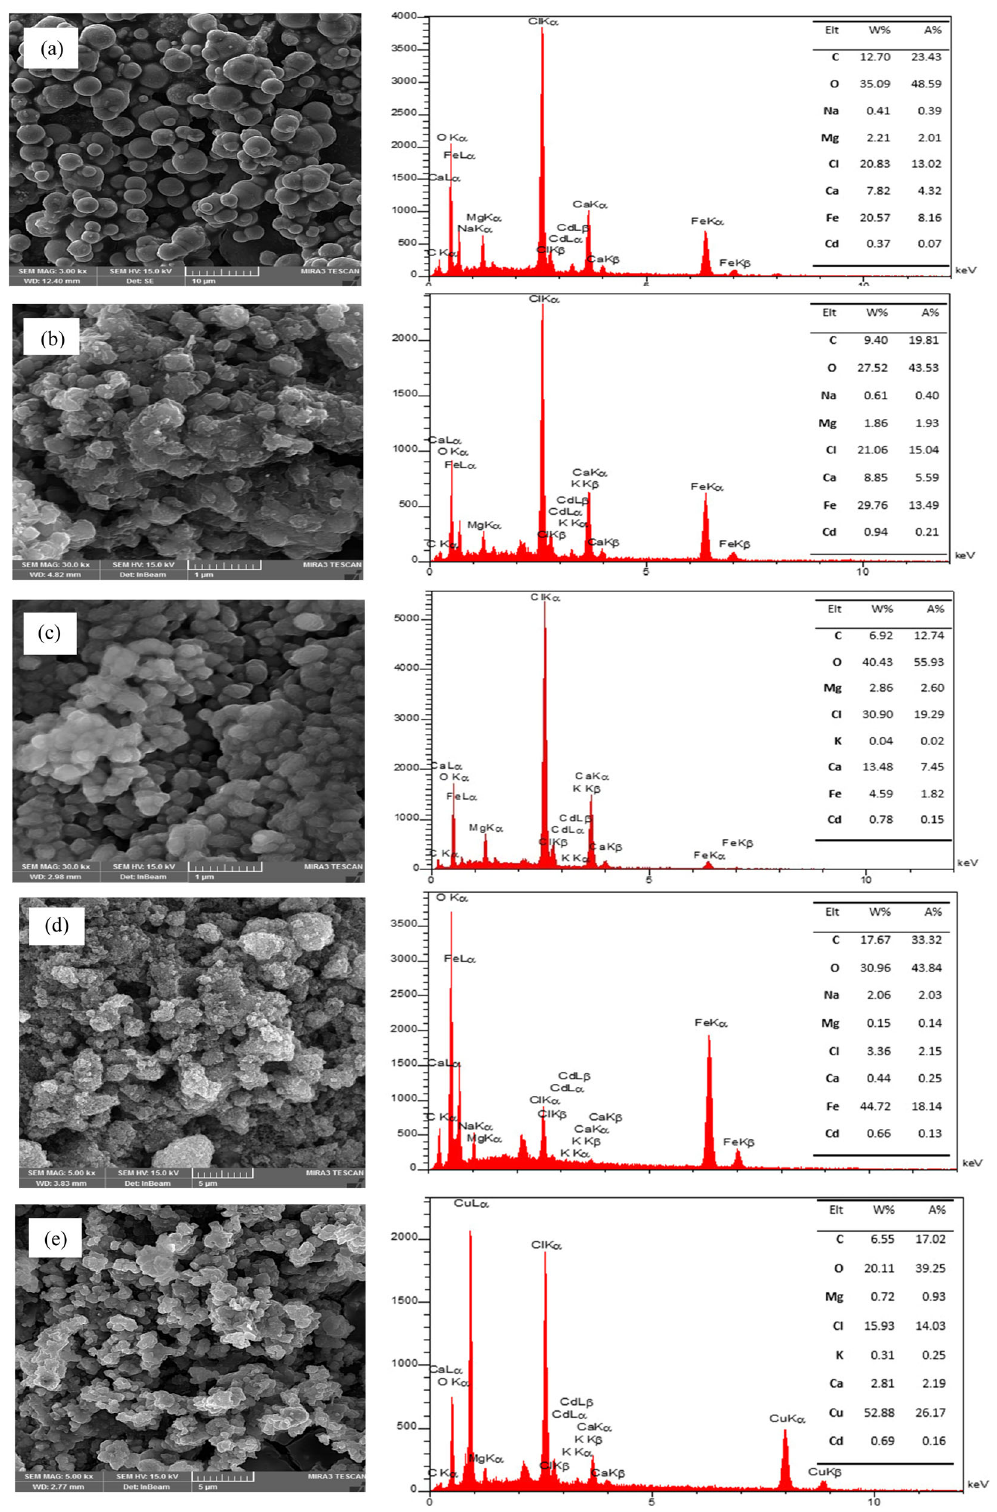
Fig. 2 FE-SEM images and EDS analysis of the electro-generated metal hydroxide particles at various conditions. a Oily saline PW (43.5 g L − 1 ); b without aeration; c oil-free PW; d low salinity (2 g L − 1 ); e copper electrodes. (Experimental conditions: pH 7, current density 25 mA cm − 2 , salinity 43.5 g L − 1